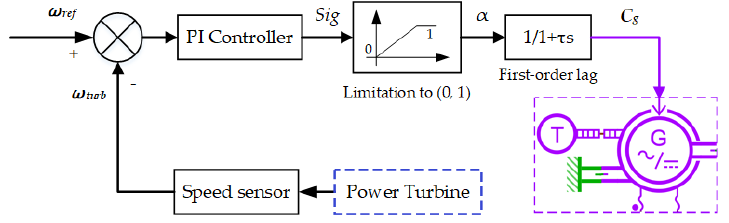
Figure 3. Generator model and its external control diagram.